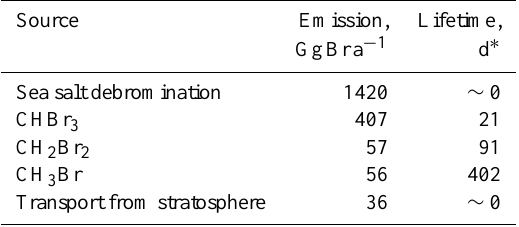
Table 1. Global sources of tropospheric bromine in